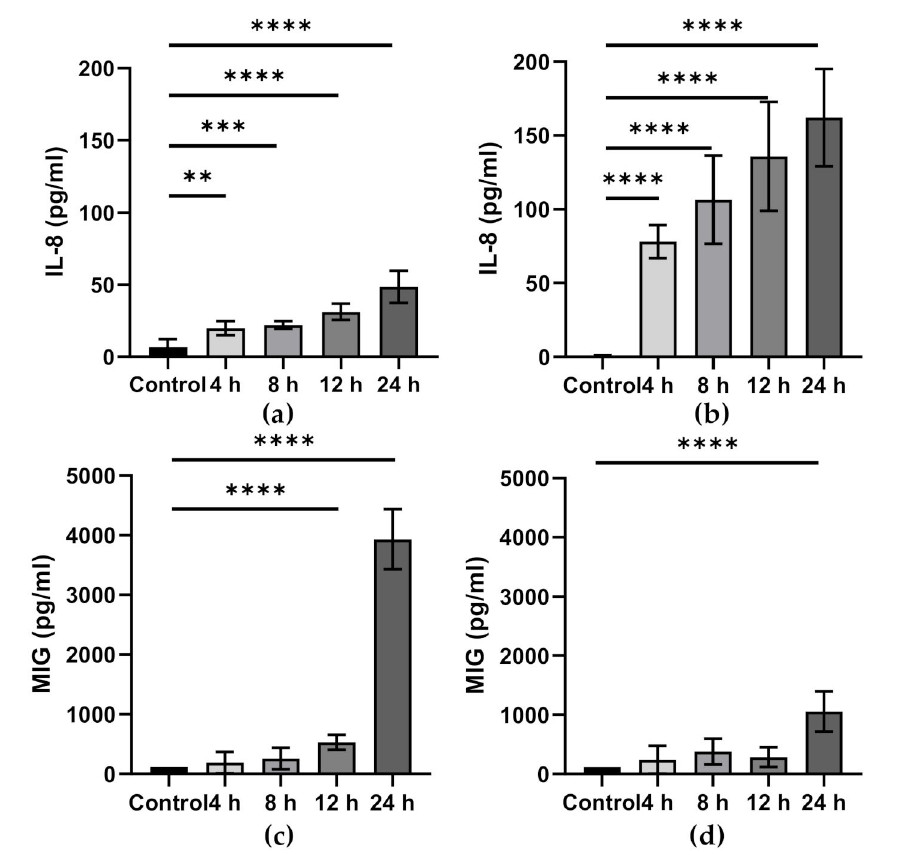
Figure 3. IL-8 and monokine induced by gamma interferon (MIG) production by Caco-2 cells stimulated with a cocktail of cytokines (TNF- α (5 ng/mL), IFN- γ (50 ng/mL), and IL-1 β ) in a Tran- swell system; cytokines were added to the basolateral compartment, and apical and basolateral supernatants assessed for IL-8 and MIG by Luminex. Controls are unstimulated. ( a ): Apical IL-8 production. ( b ): Basolateral IL-8 production. ( c ): Apical MIG production. ( d ): Basolateral MIG production. Data are the mean ± SEM from three experiments and are not previously published. Sig- nificance was determined by one-way ANOVA with Dunnett’s multiple comparison tests; ** p < 0.01, *** p < 0.001, and **** p <